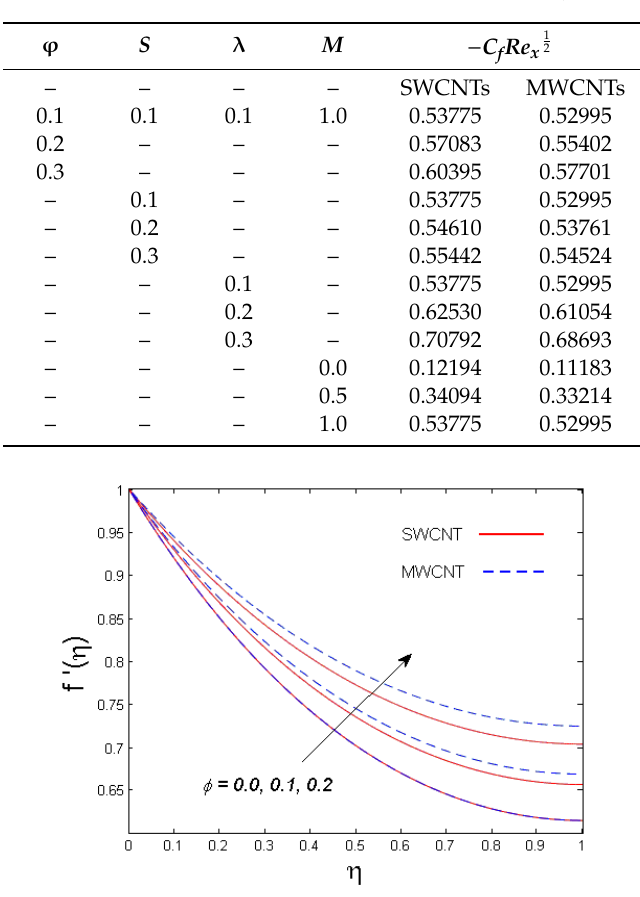
Figure 2. The illustration of φ versus f ’(η).